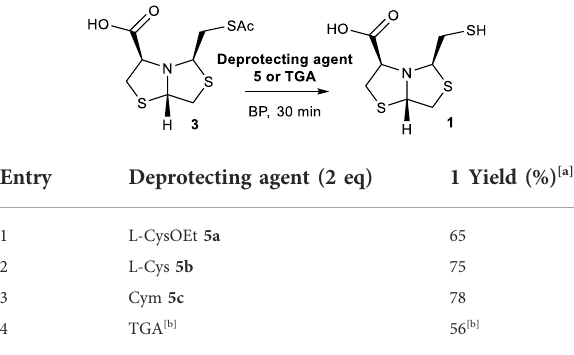
TABLE 2 Deprotection of thioester 3 under optimized conditions MeOH:BP (1:9), pH 8, rt, 30 min, aminothiol 5 (2 eq) or TGA (2 eq).